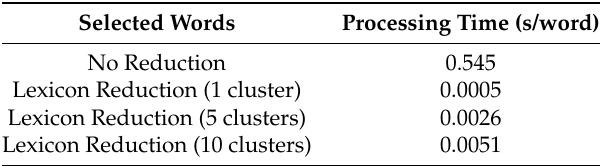
Table 6. Processing time of word search and LM vs. words